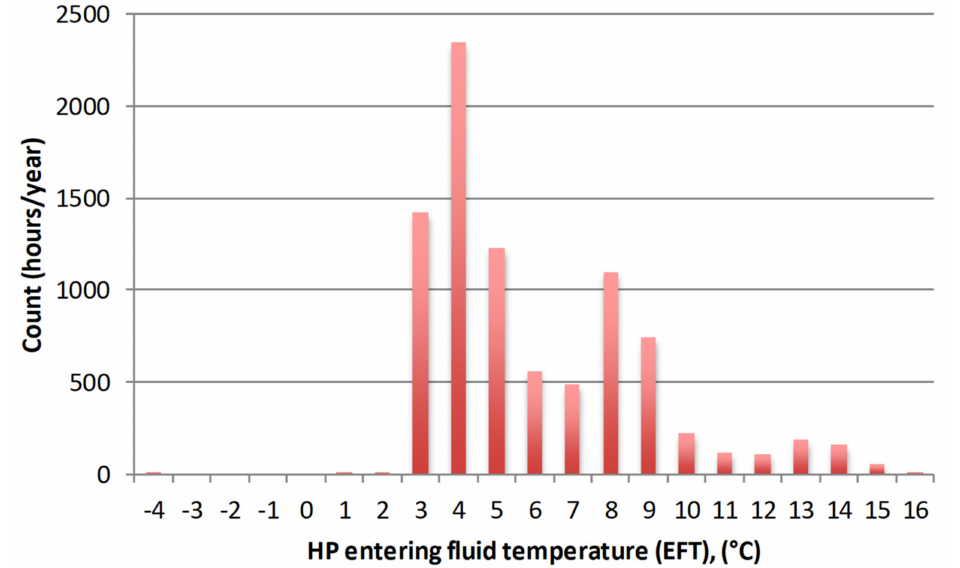
Figure 11. Frequency (hours) for 1 ◦ C binned HP entering fluid temperature (EFT). Some 90% of the hours of HP EFT is within a narrow range between 3 and 9 ◦ C, especially from 3 to 5 ◦ C over 60% of the time. It may be normal during the winter period, but in summer operation, more hours with EFT between 10 and 16 ◦ C are expected, since the HP evaporator works directly against the AHU-cooling